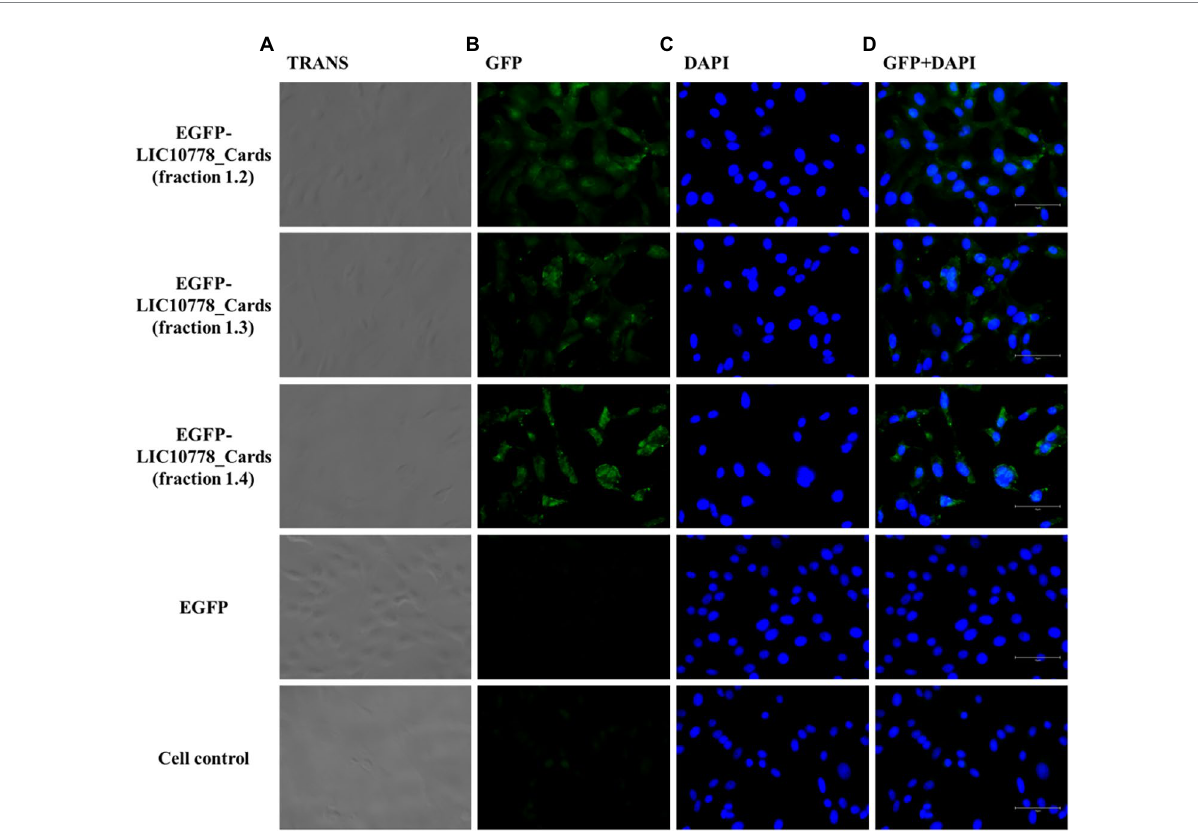
FIGURE 7 EGFP-LIC10778_Cards binding to VERO cells. Purified samples of EGFP-LIC10778_Cards protein were incubated with VERO cells, previously cultured for 5 h in serum-free media. Following 2 h incubation with the fluorescent proteins, including recombinant EGFP as negative control, cells were washed, fixed in 4% PFA, and incubated with DAPI for nuclear staining. Resulting fluorescence was observed under a fluorescence microscope (EVOS M5000, Thermo Fisher Scientific), considering available filter TRANS (transmitted light; A) , GFP (B) and DAPI (C) , and image magnification to 400x. In (D) , overlap of the same images from GFP and DAPI filters are represented, and white bars on the bottom right of each image represent 75 μ m in size. Cell control represents non-treated cells. Results were obtained from two independent